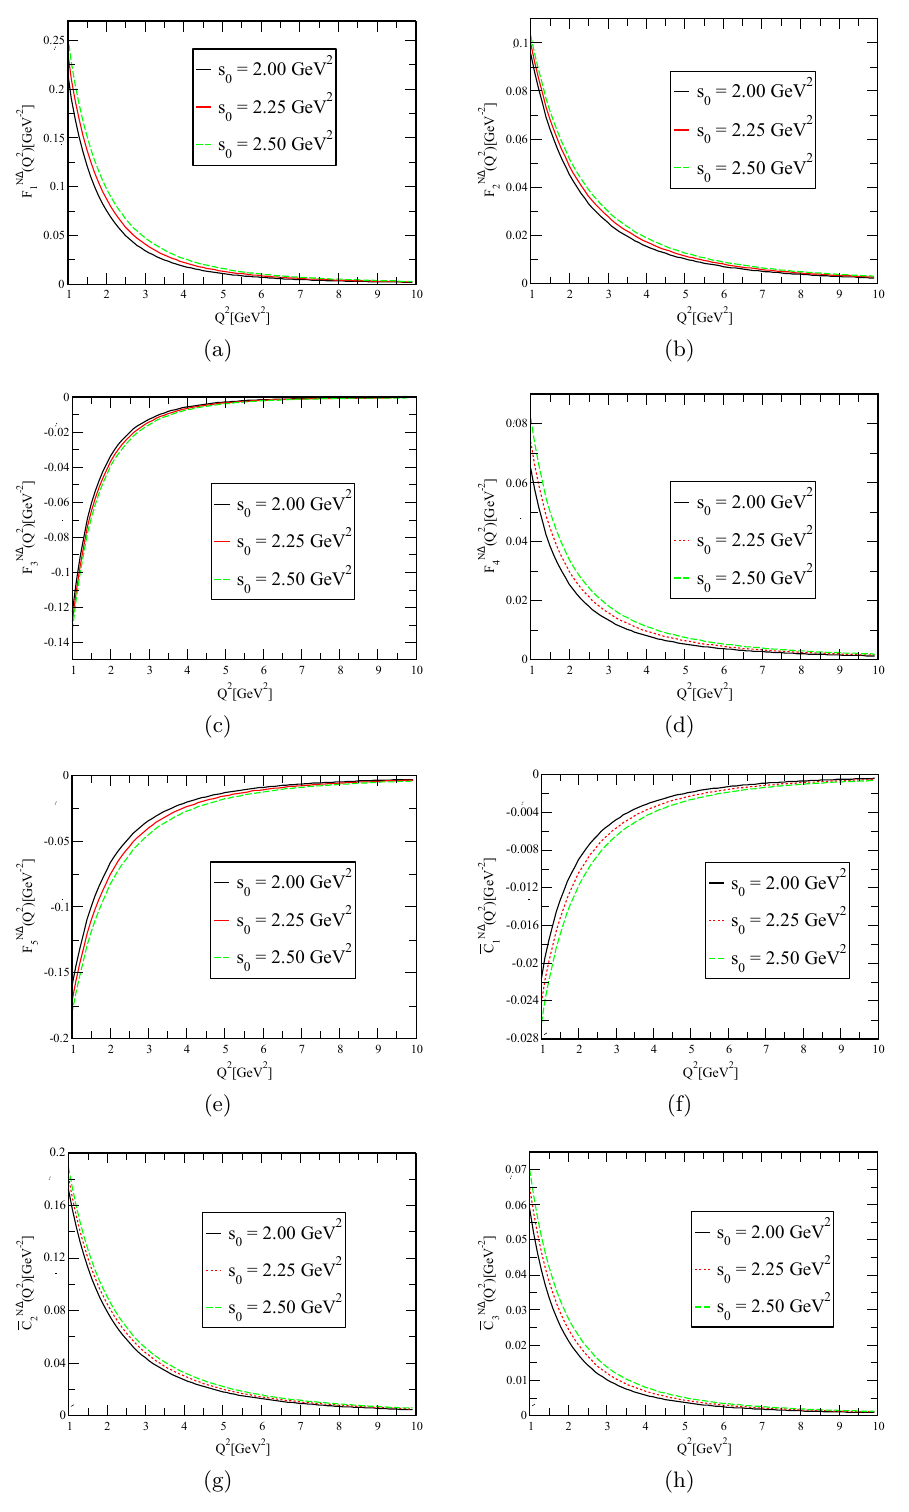
Figure 4 . The dependence of the N → ∆ transition GFFs on Q 2 at fixed values of the s 0 , average M 2 and set-II